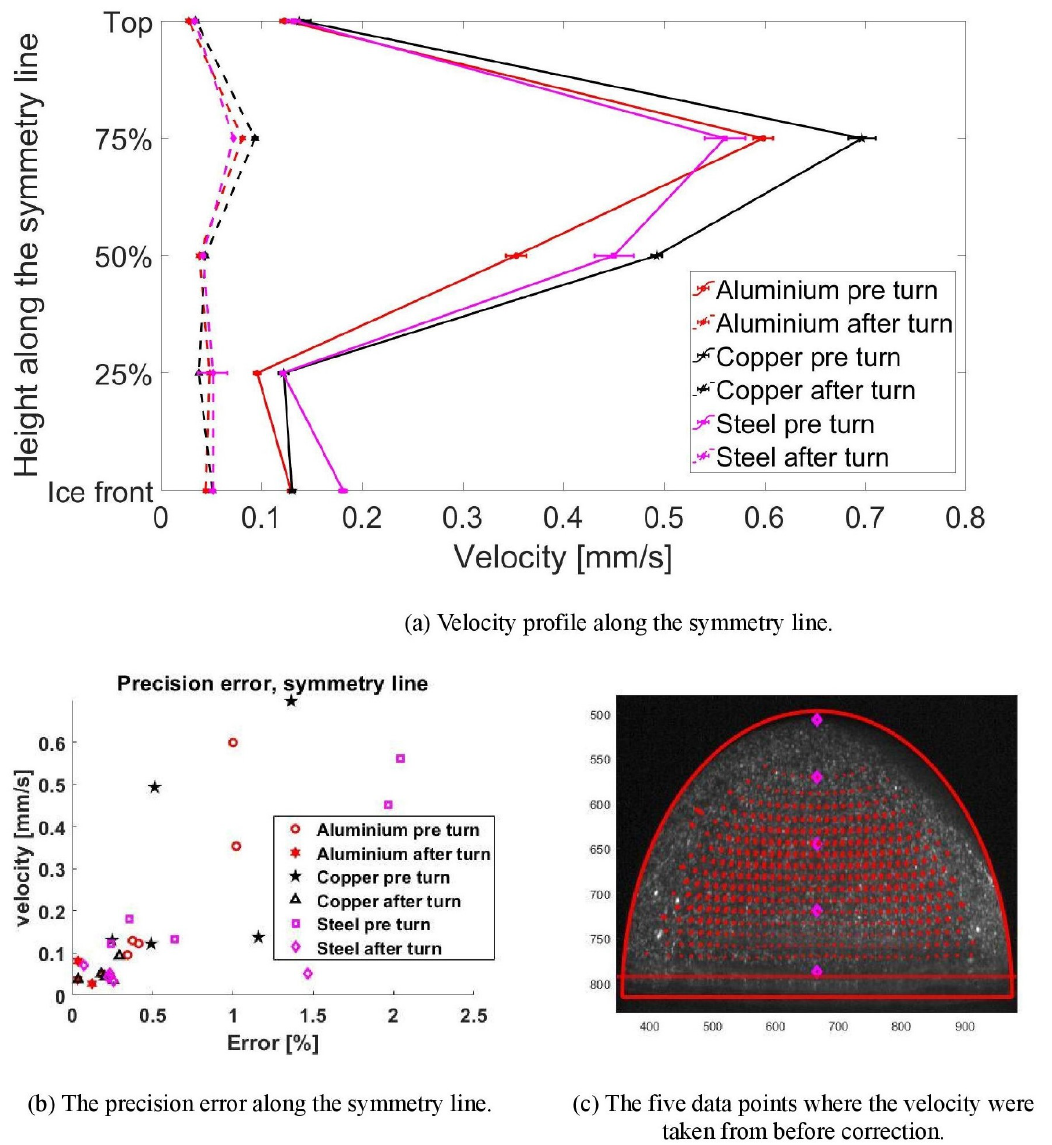
Figure 5. In ( a ), the velocity profile for the different substrate materials can be seen throughout the droplet for pre and after turn. In ( b ), the precision error can be seen for all the points in ( a ). In ( c ), the velocity field after application of the correction method proposed by Kang et al. [33] is displayed together with the five data